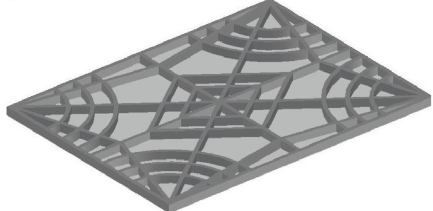
Figure 8: ETH Zurich’s lightweight concrete floor slab.